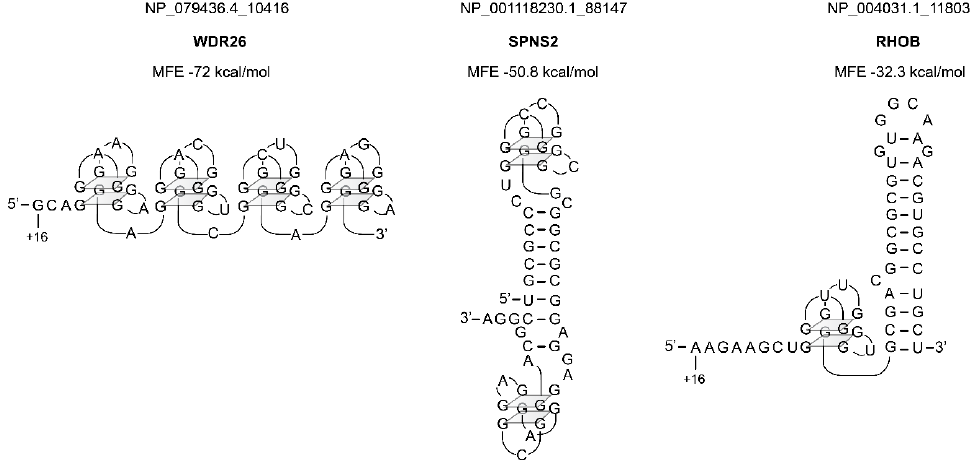
Figure 7. Representation of three structures containing G-quadruplexes selected in the human genome. The position of nucleotide +16 is indicated. The names of the genes are shown in bold.